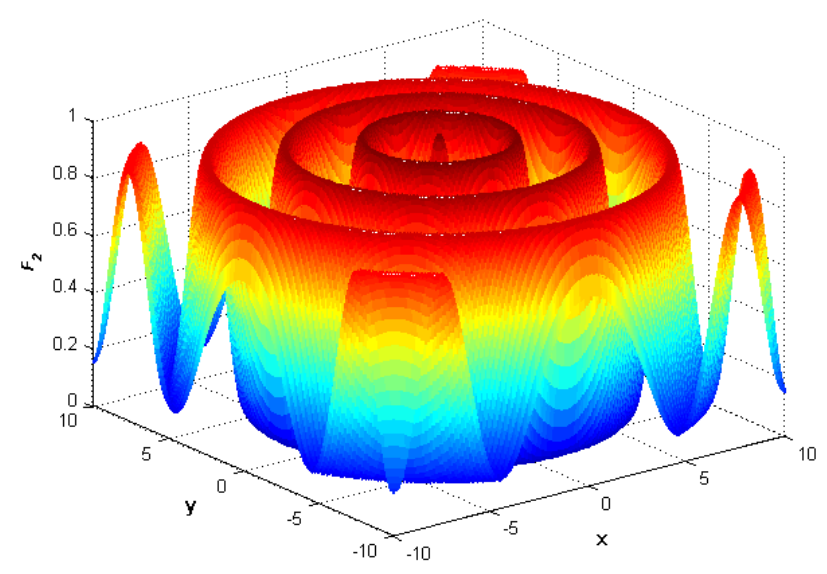
Figure 6. Plot of test function F 2 .